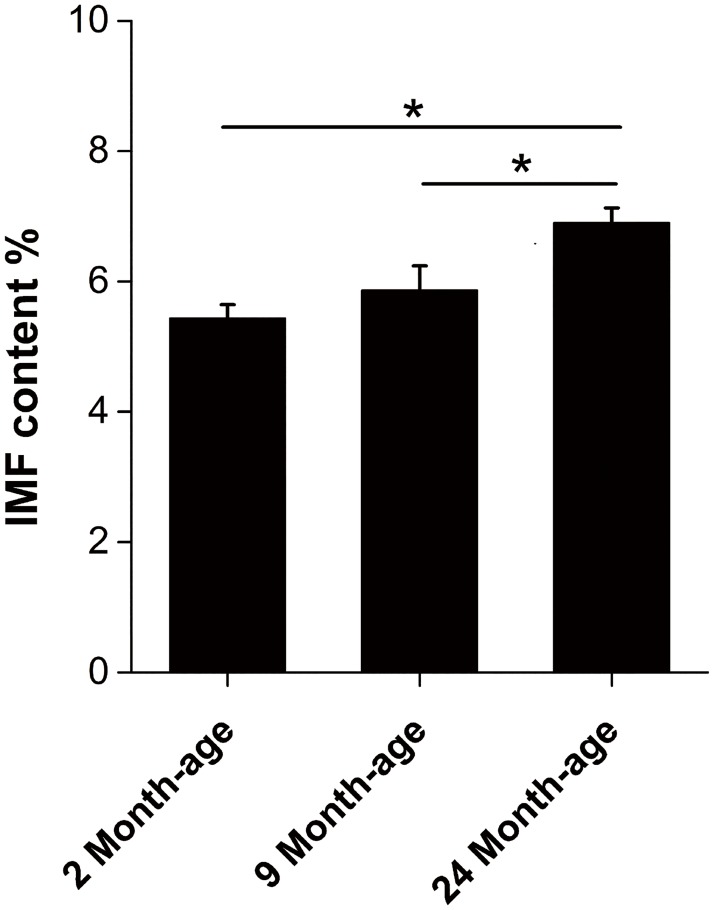
IMF content in 2-month age, 9-month age and 24-month age goats.IMF, intermuscular fat. * represents P<0.05.